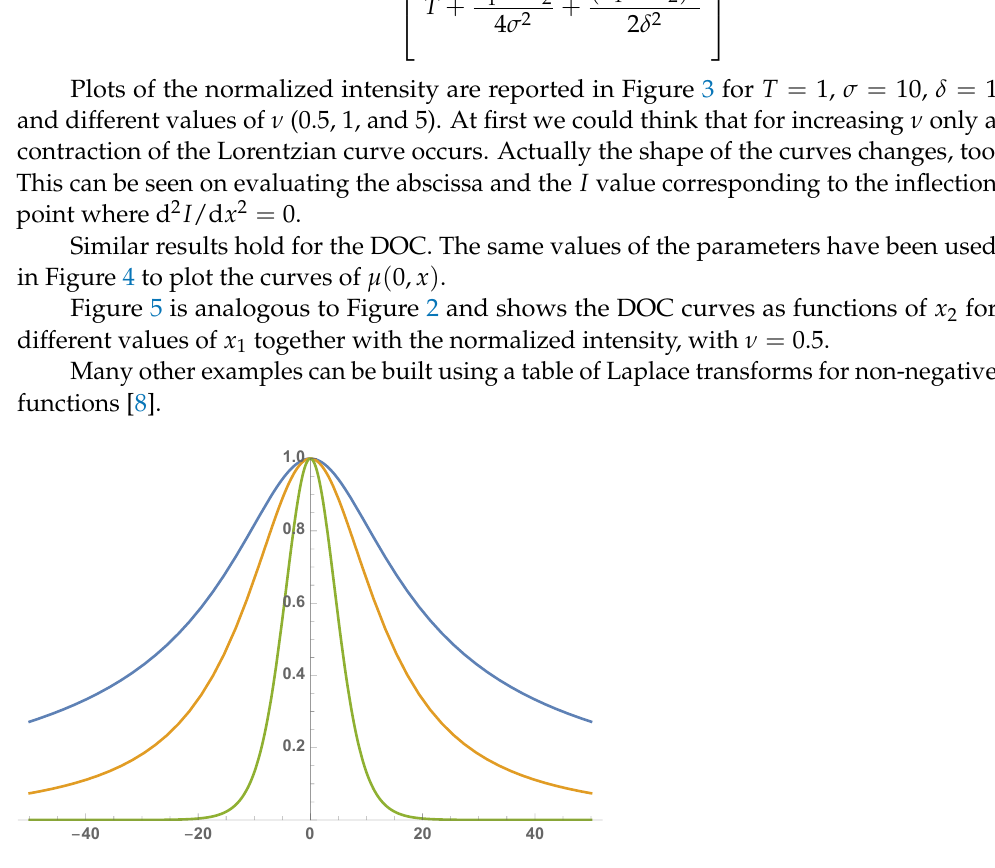
Figure 3. Intensity profiles vs. x given by Equation (15), for T = 1, σ = 10, δ = 1 and ν = 0.5,1,5 (from the widest to the narrowest